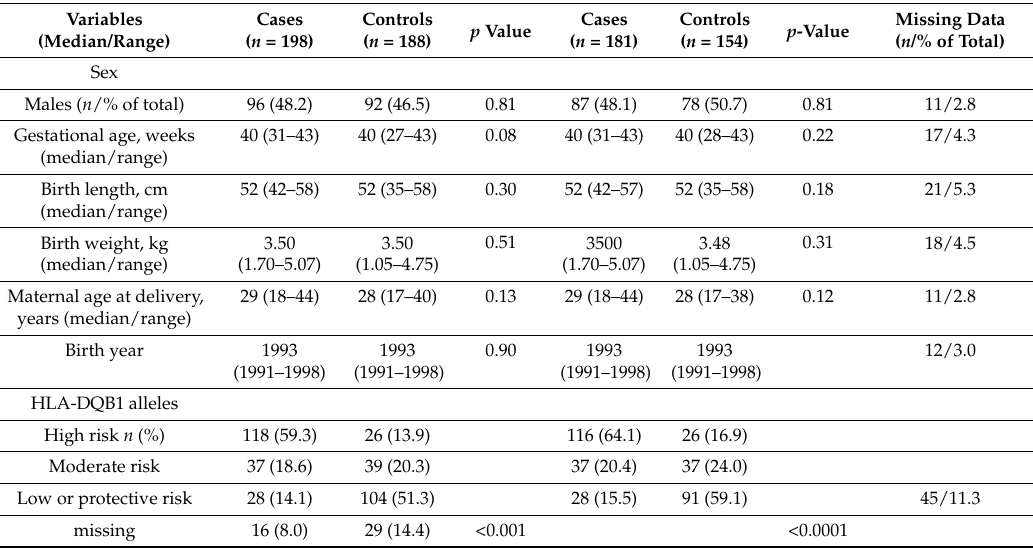
Table 1. Characteristics of study participants.